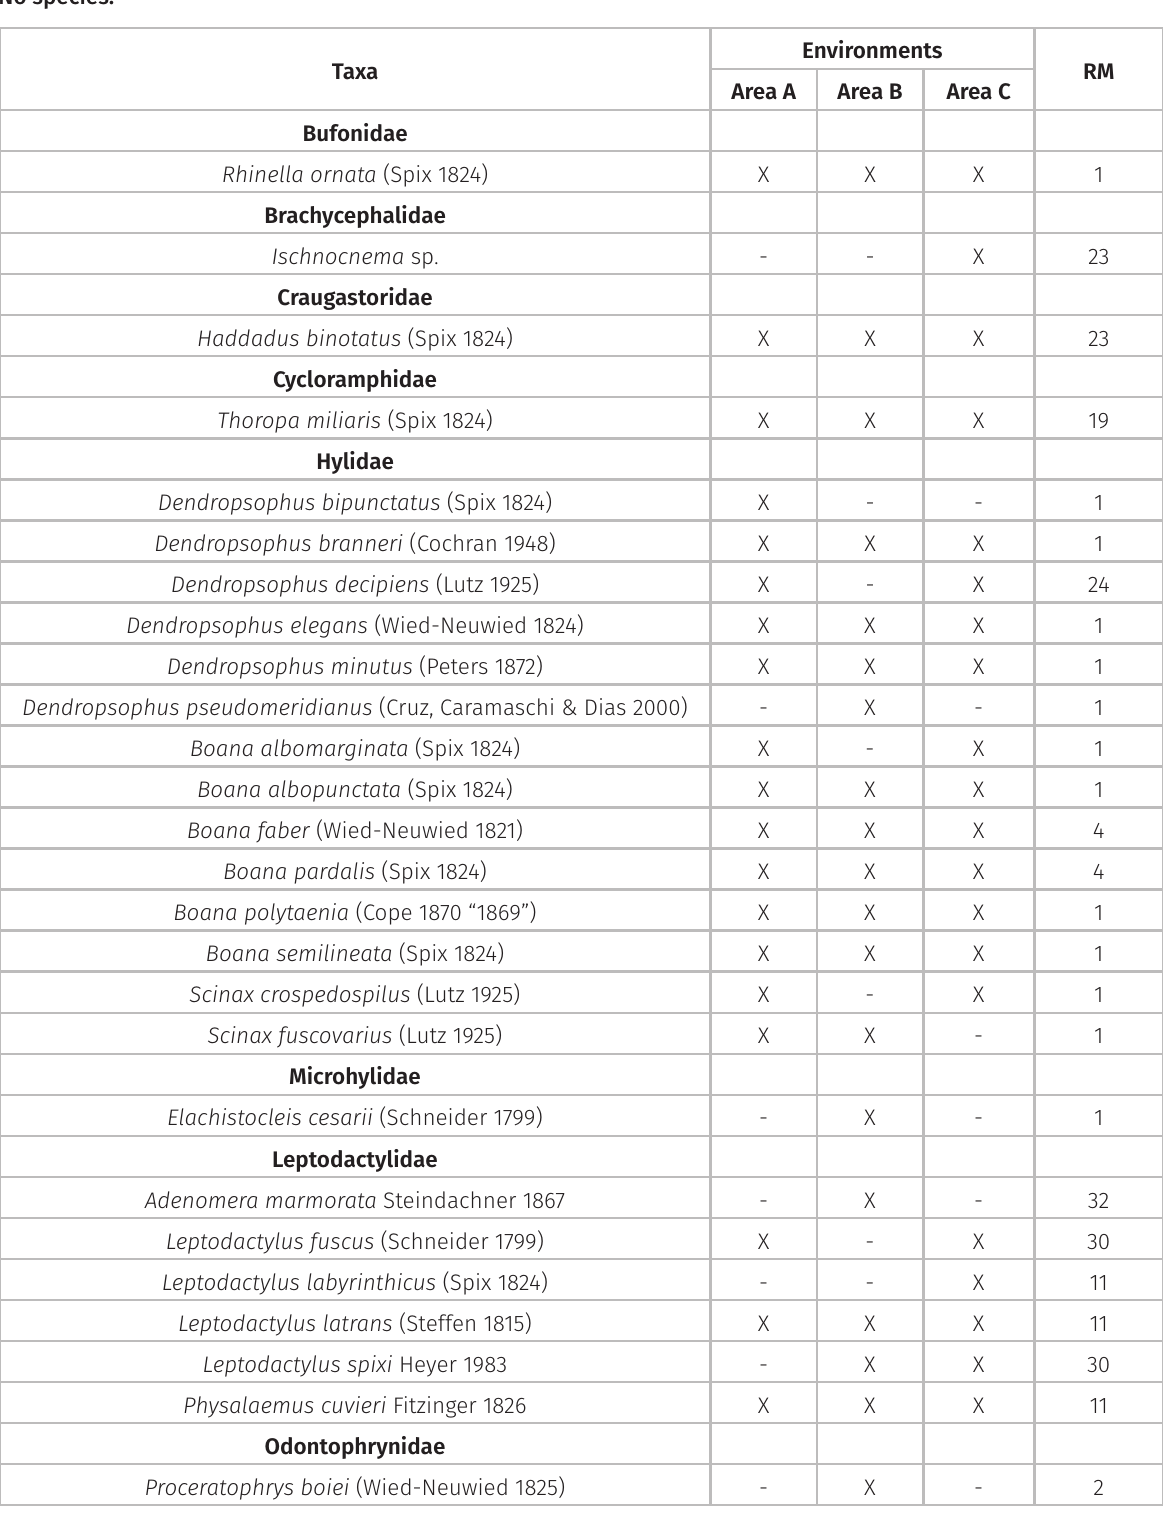
Table II. List of anurans species and habitats where they occur in the Municipality of Barão de Monte Alto, State of Minas Gerais, Brazil: Area A, Area B and Area C. RM – Reproductive Modes (According to Haddad & Prado 2005). (-) – No